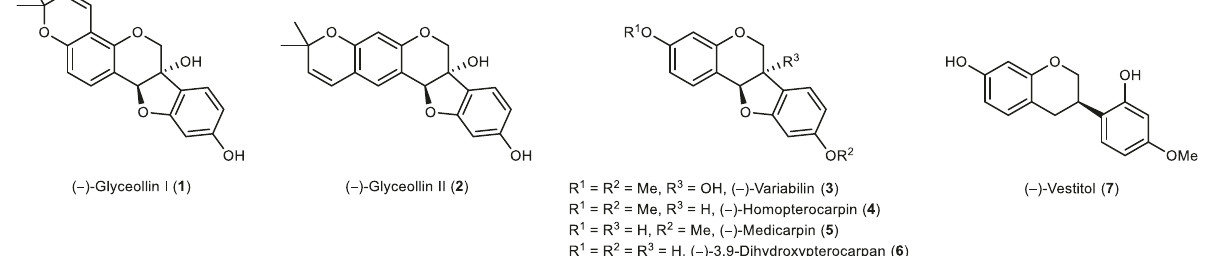
Fig. 1 Examples of iso fl avonoids. Bioactive natural products with 6a-hydroxypterocarpan skeleton ( 1 – 3 ) and selected other